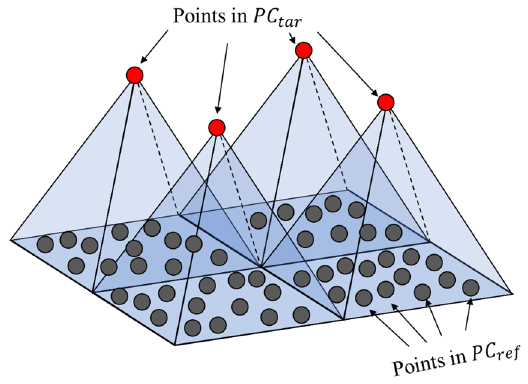
Figure 6. Relationship between the density of 𝑷𝑪 𝒓𝒆𝒇 and 𝑷𝑪 𝒕𝒂𝒓 .